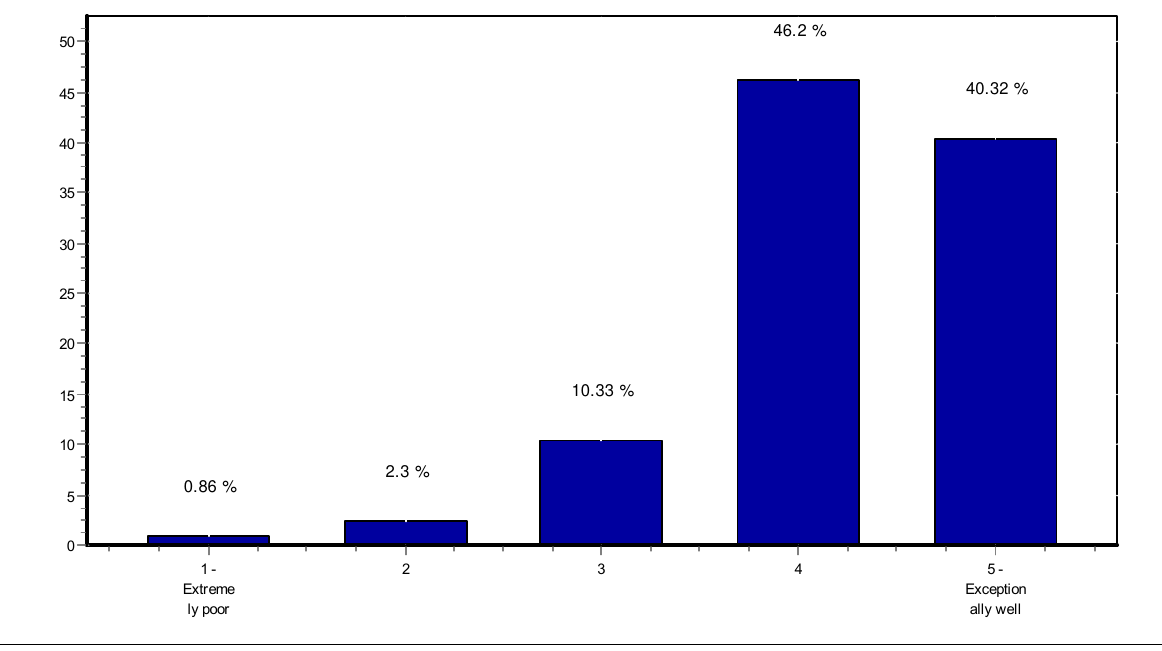
Fig. 4. Quality of information available at event